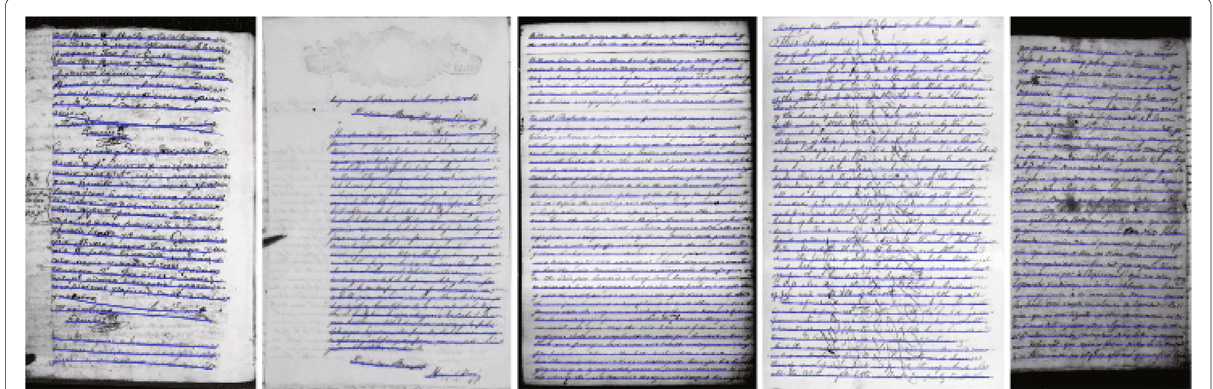
Fig. 8 Results of the proposed method on ICDAR 2015 dataset. As shown, our algorithm is able to find exact textlines in the presence of non-text objects, page border, metadata, and uneven background